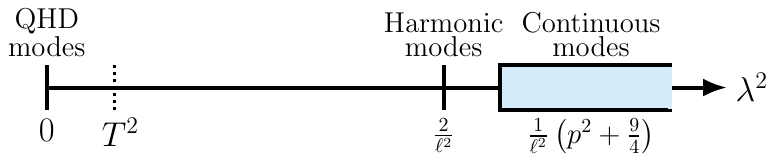
2 (cid:12)eld modes with an on-shell mass of